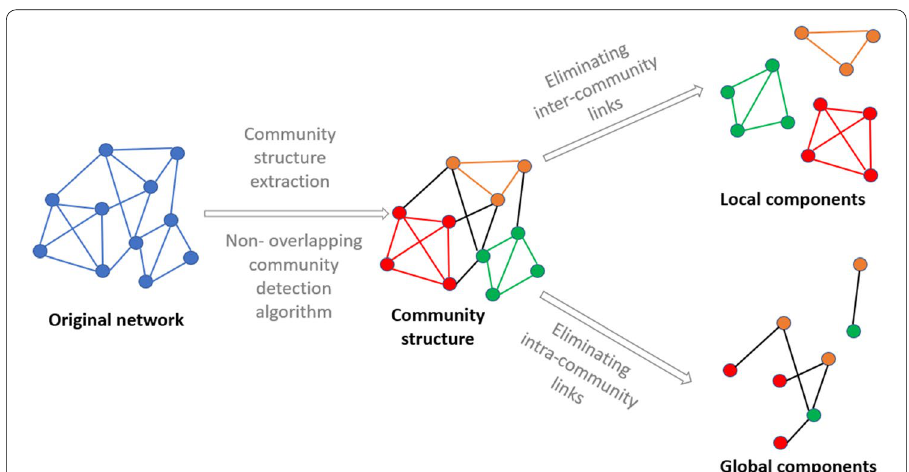
Fig. 1 The component structure detection algorithm. First, the community structure of the network is uncovered. Second, the local components are obtained by eliminating inter-community links from the community structure.Third, the global components are obtained by eliminating intra-community links and subsequent isolated nodes from the community